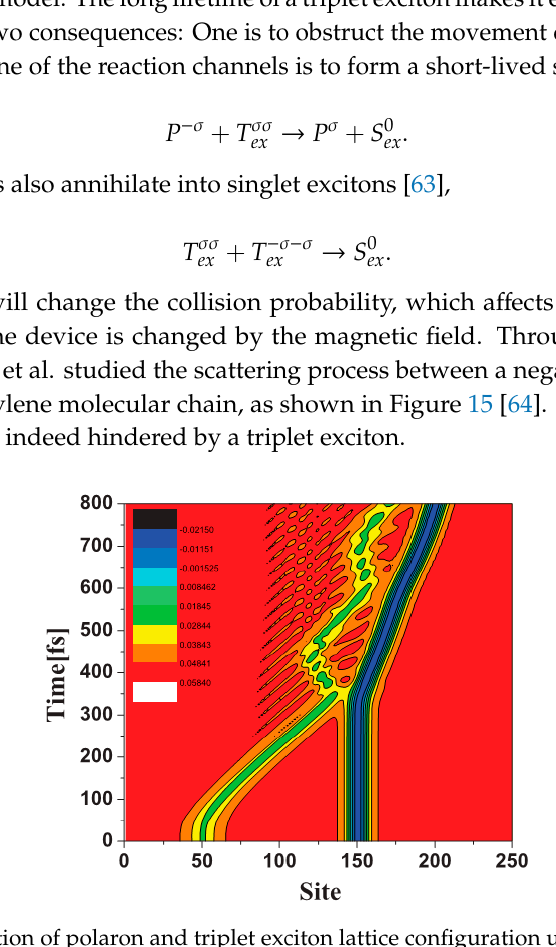
Figure 14. MC curve with the magnetic field in the case of different hyperfine equivalent fields, B hf = 3.5, 5.5 and 7.5 mT. Symbol × is the experimental value at B = 100 mT. By Qin et al. [34] with the permission of Applied Physics Letters.